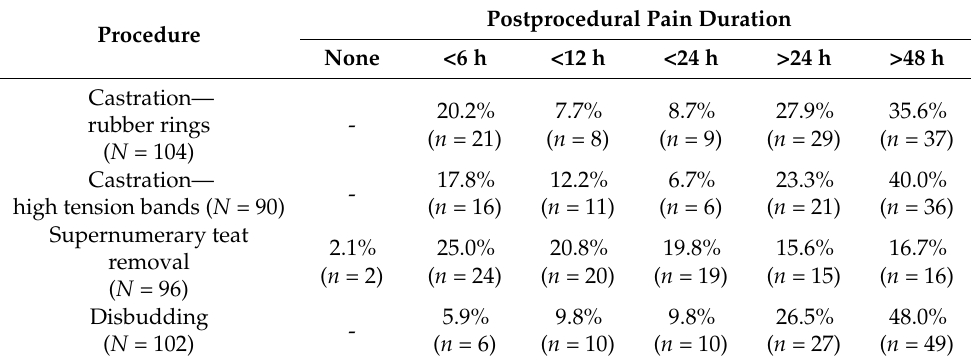
Table 7. The percentage and number of veterinarians that specified postprocedural pain durations across certain husbandry procedures.